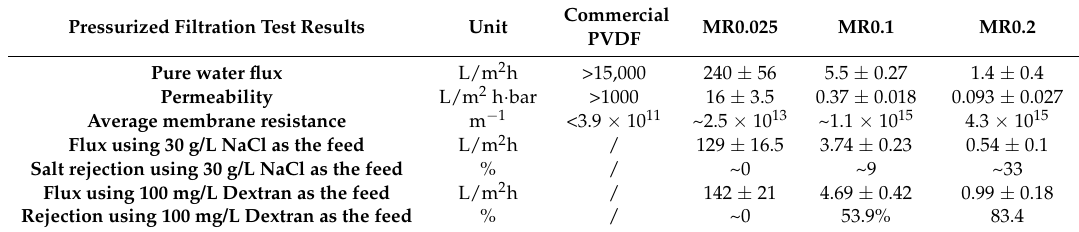
Table 1. Pressurized filtration test results of composite PVA/PVDF membrane using feed solutions of Milli-Q water, 30 g/L NaCl or 100 mg/L dextran, under TMP of 15 bar at room temperature. The flux was recorded after the stabilization of 30 min. The membrane resistance (R m ) was calculated based on R m = ∆ P , where ∆ P, µ and J indicated the trans-membrane pressure, viscosity of Milli-Q water and µ J corresponded pure water flux, respectively.